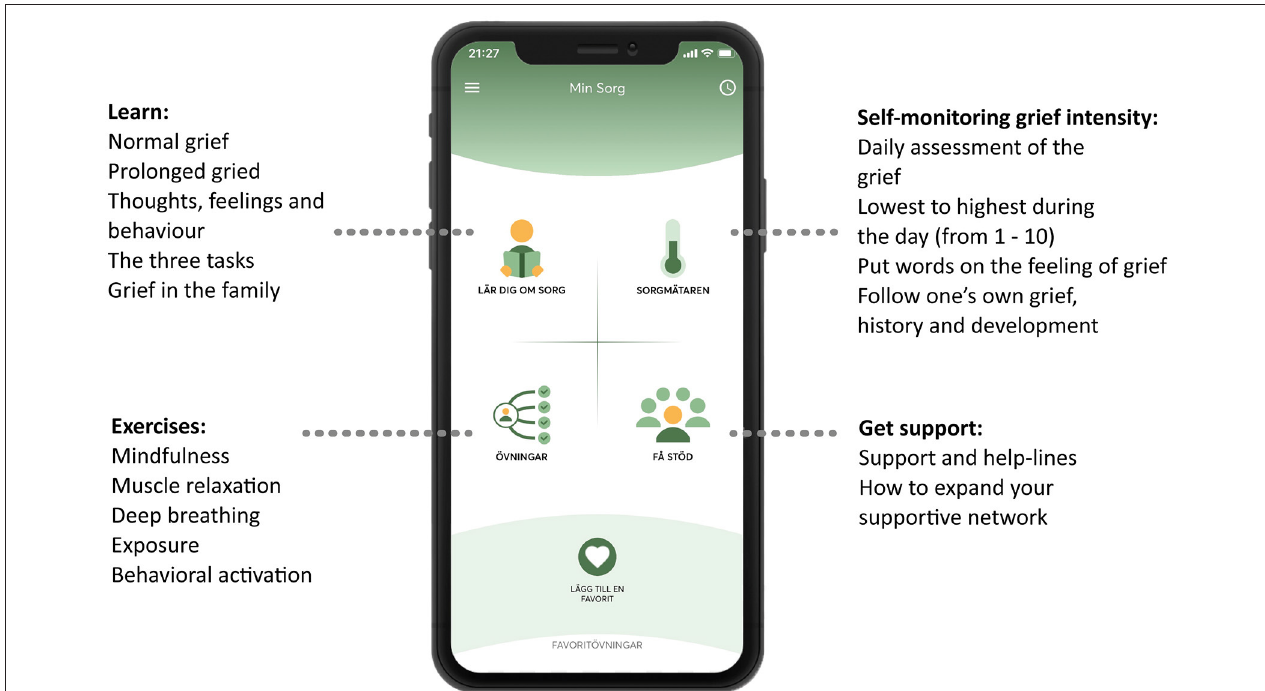
FIGURE 1 | Structure of the My Grief